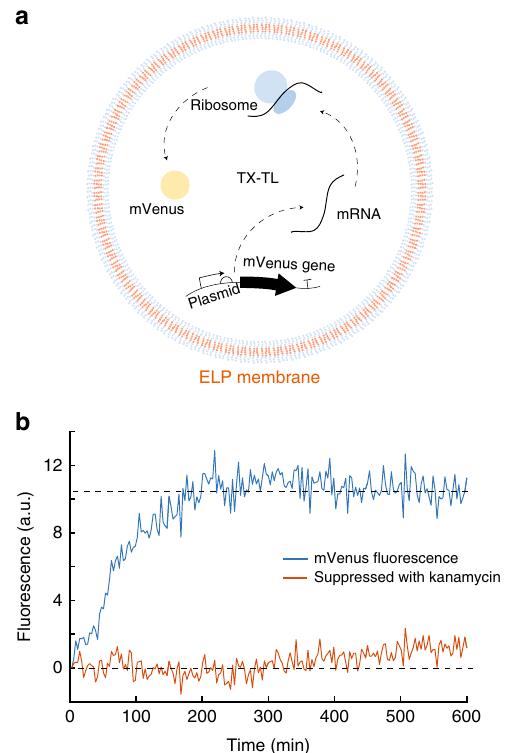
Fig. 2 Protein expression inside ELP vesicles. a Illustration of the expression of mVenus inside an ELP vesicle containing bacterial cell extract TX-TL. b Time-dependent fl uorescence of expressed mVenus (blue) and fl uorescence of kanamycin-suppressed expression (red). The dashed lines are a guide to the